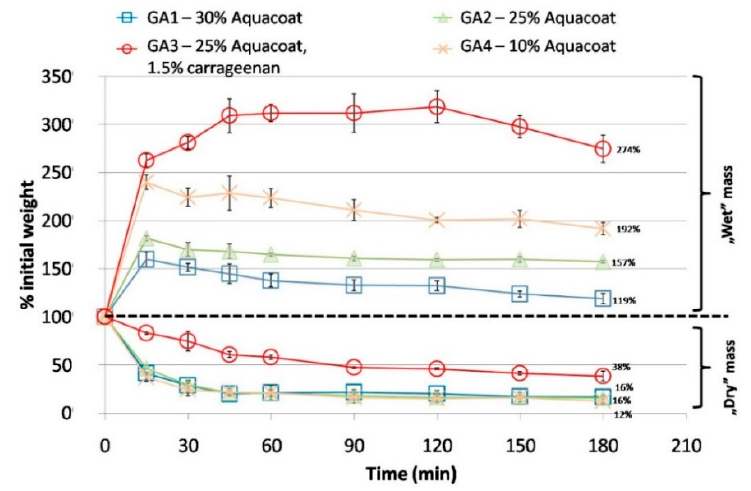
Figure 4. Changes in the weight of the gelatin—Aquacoat films during acid treatment: wet and dry mass.